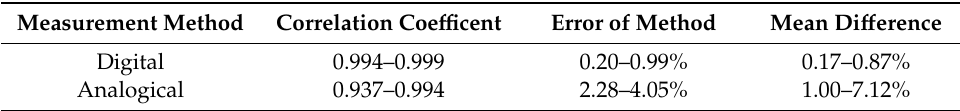
Table 12. Range of correlation, error (%), and mean di ff erence (%) values of the two measurement methods